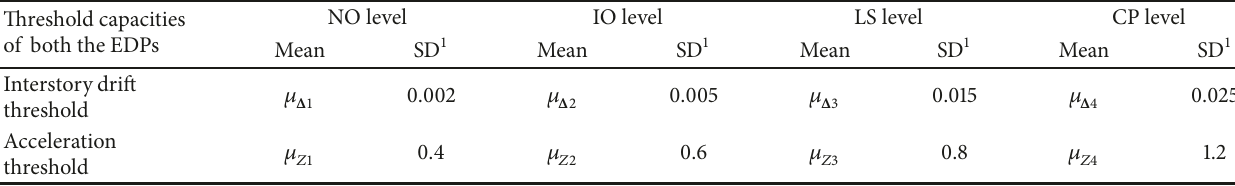
Table 1: Threshold capacity values of interstory drift and peak floor acceleration.